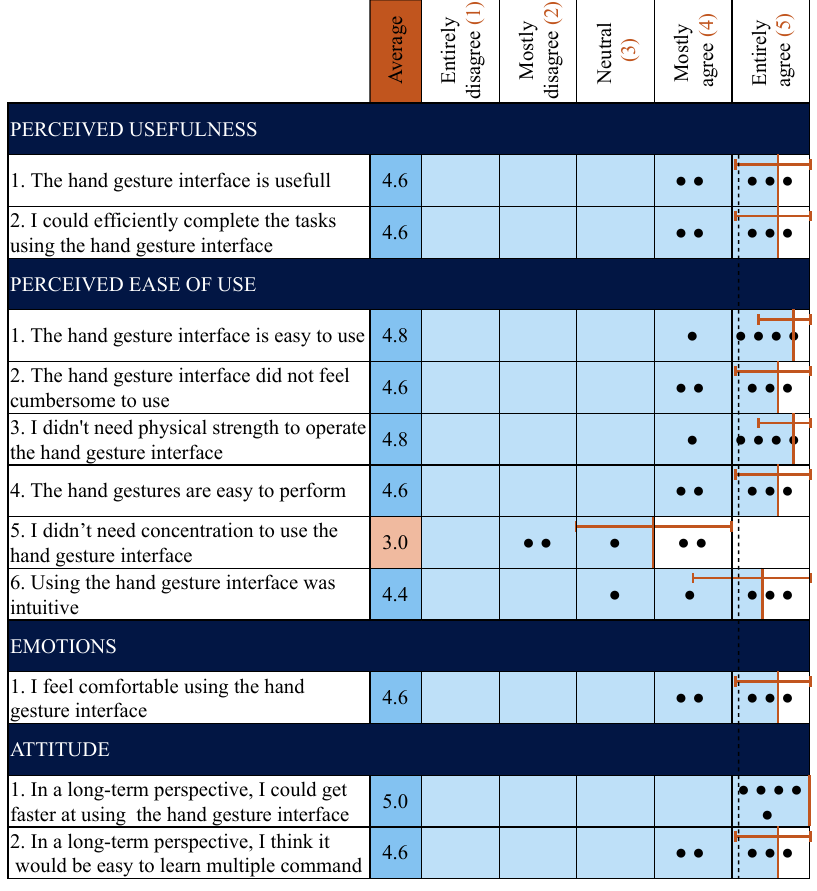
Figure 13. Post experiment questionnaire